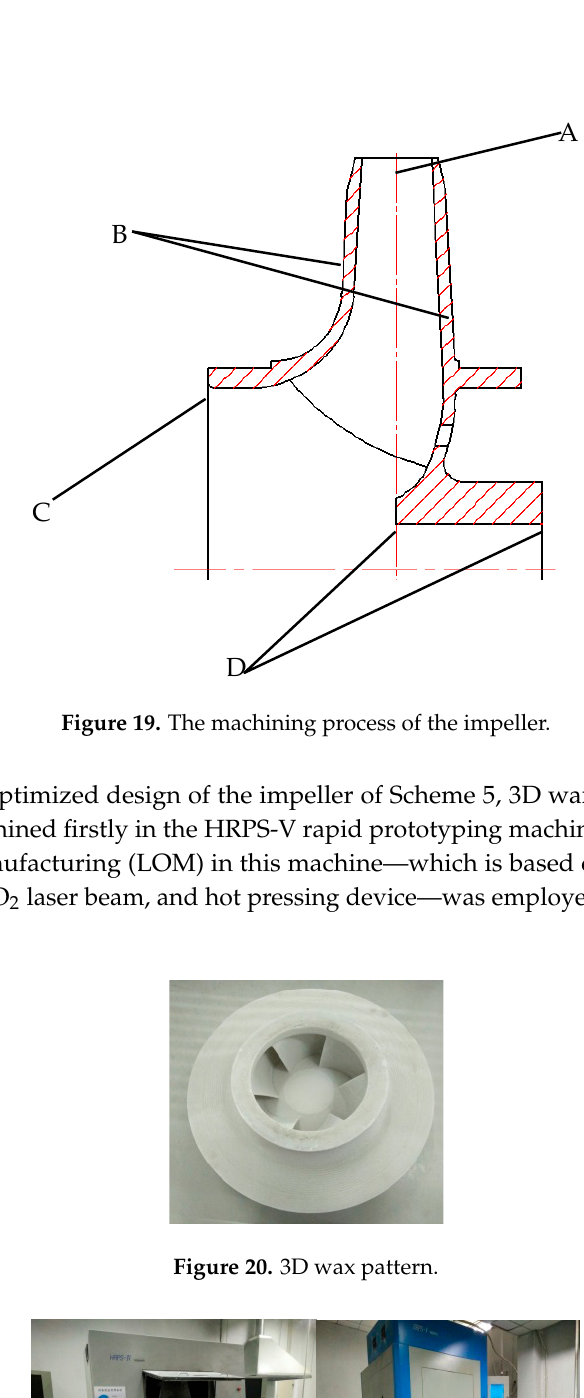
Figure 21. HRPS-V rapid prototyping machine.